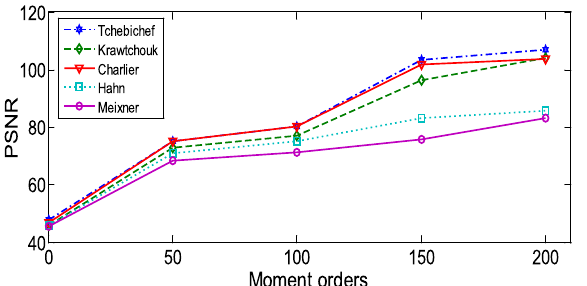
Fig. 9 PSNR of the reconstructed signal "MIT-BIH Rec. 101" using Tchebichef, Krawtchouk , Charlier, Hahn, and Meixner moment with Householder methods